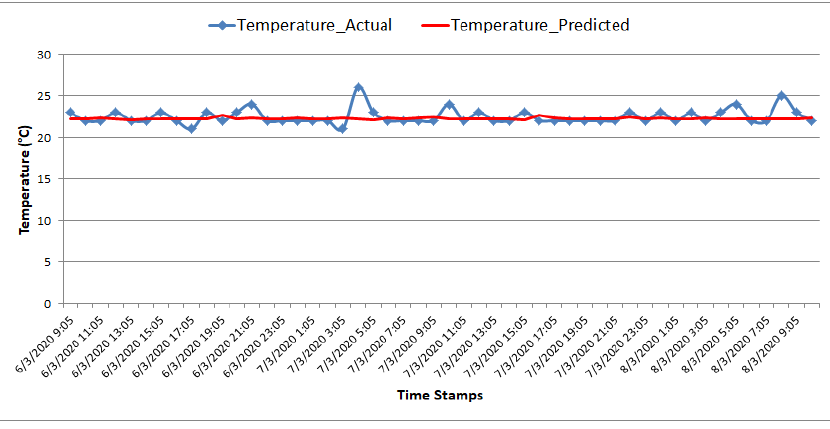
Figure 22. Predicted values of Air Temperature after every 5 min vs. Actual values.